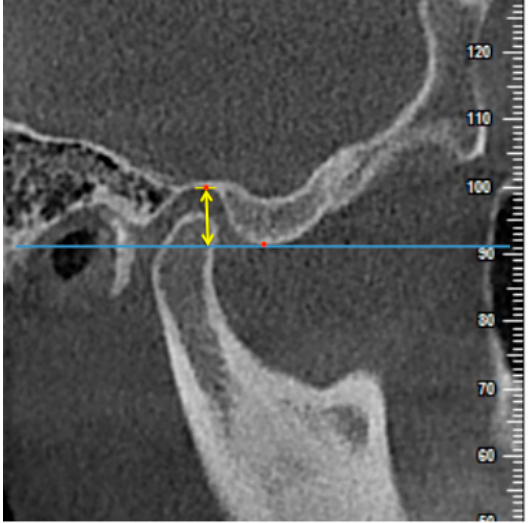
Figure 6. The measurement of the height of the articular eminence (AEH) on the central sagittal slice. The perpendicular distance between the line parallel to the FH plane through the crest point of the articular eminence (blue line) and the highest point of the glenoid fossa was measured (yellow arrow).